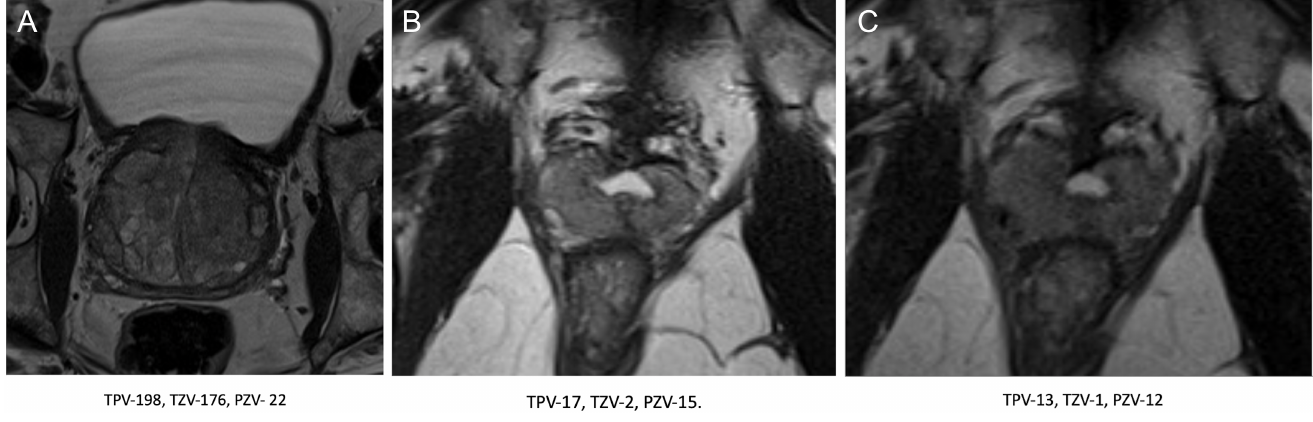
Figure 4. a-c. T-2 weighted images of prostate (axial view) before and 4 month and 1.5 year after HoLEP procedure (volume in cc).